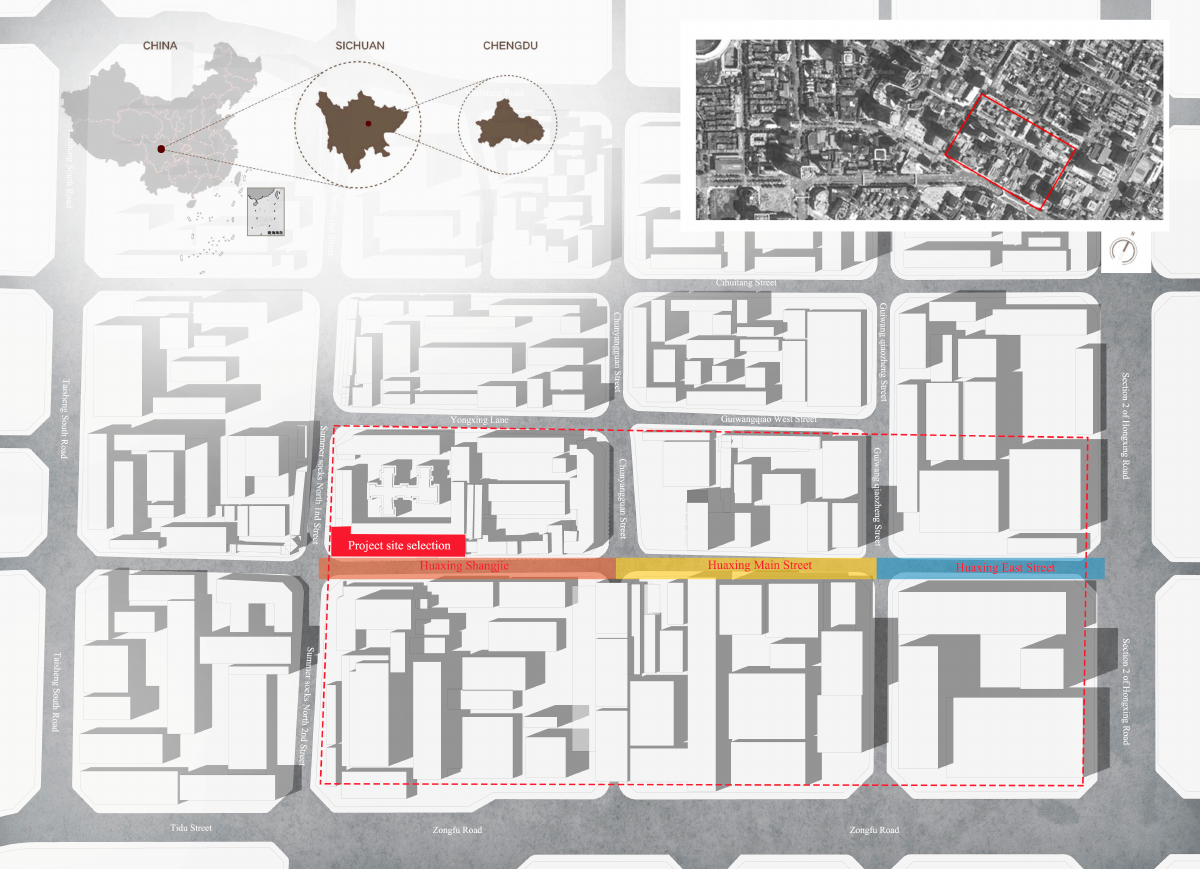
Figure 3. Project Location.